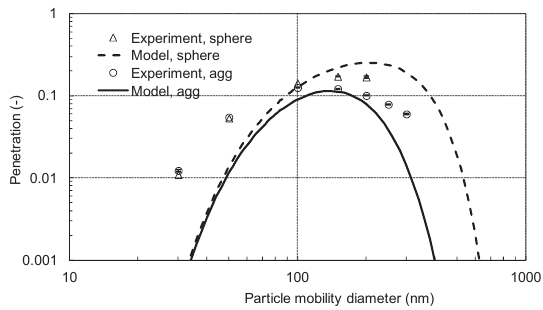
Fig. 7 Silver particle penetration as a function of the mobility size (test filter: HE 1073, face velocity: 5.3 cm/s). The error bars are included but they are smaller than the